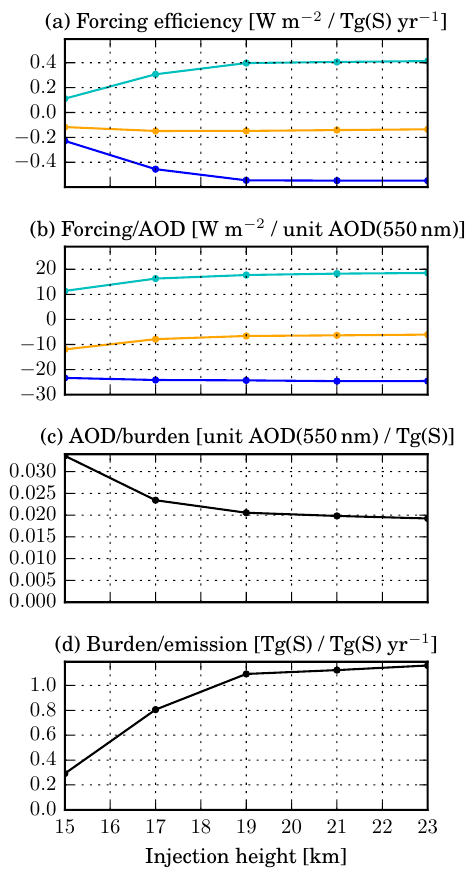
Figure 10. Forcing efficiency and its decomposition (as in Fig. 7) for the z _KM simulations with different injection heights.